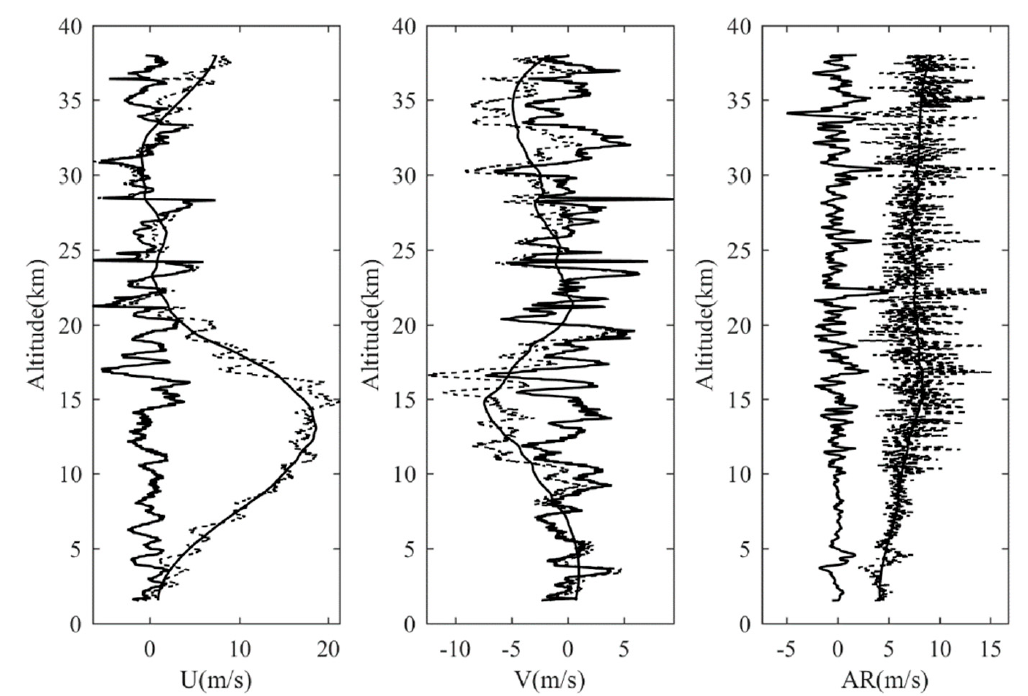
Figure 5. Original profile and extracted fluctuations of the wind speed component at night on 24 September. From left to right: zonal wind, meridional wind, and ascent rate profiles. The dashed lines represent the original horizontal wind field and ascent rate, the smooth curve represents the extracted background components, and the fluctuation curve near zero represents the extracted wind speed fluctuation (The vertical wind fluctuation curve takes a 31-point moving average.). For three-dimensional wind fluctuations, the average vertical wavenumber spectrum is calculated according to Equation 11. For the meridional and zonal wind fluctuations, the amplitude spectrum − 4 − 2 is still fitted in the wavenumber range of 9.97 × 10 – 7.5 × 10 cycle / m, and the “center of mass” − 2 wavenumber k nc = 2.8 × 10 cycle / m. For vertical wind fluctuations, when smoothing and filtering are performed to eliminate the e ff ects of noise and turbulence, the di ff erence of smooth points has great influence on the spectrum structure at large wavenumbers. In order to obtain a more accurate spectrum − 4 − 3 − 3 slope, the wavenumber range for linear fitting is 9.97 × 10 – 4.8 × 10 cycle / m, 4.8 × 10 cycle / m corresponds to a vertical scale of 210 m, which is also a smooth window for vertical wind fluctuations. − 3 The corresponding “center of mass” wavenumber is 1.9 × 10 cycle / m. The calculated results of the average vertical wavenumber spectrum for zonal, meridional, and vertical wind fluctuations at each height interval are shown in Figure 6. The power spectrum density corresponding to the “center of mass” wavenumber is defined as the spectrum amplitude of the entire vertical wavenumber spectrum. The calculation results of the spectrum slope and spectrum amplitude corresponding to the normalized temperature field and three-dimensional wind field fluctuations at 2–8 km, 14–20 km, 20–26 km, 26–32 km, 32–38 km are shown in Table 2, here the fitting interval of normalized temperature spectrum is − 4 − 2 − 3 9.97 × 10 – 1 × 10 cycle / m, and the “center of mass” wavenumber is 4.7 × 10 cycle / m, excluding the interference of the turbulence